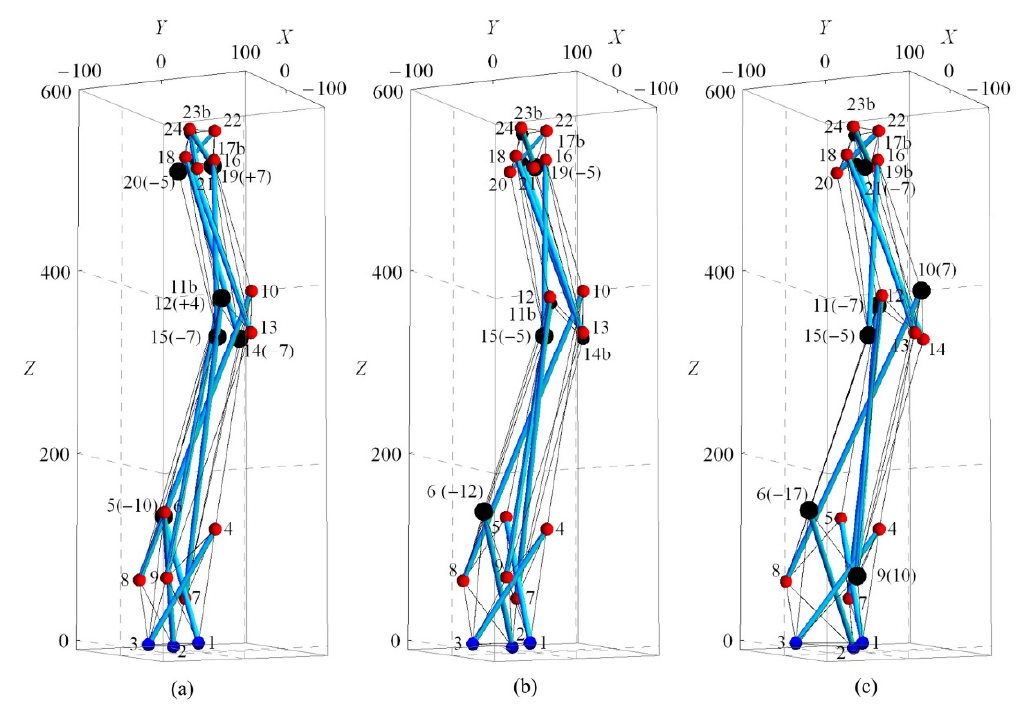
Figure 3. Self-equilibrated configuration for spine biotensegrity models ( a ) SB1, ( b ) SB2 and ( c ) SB3 [5].